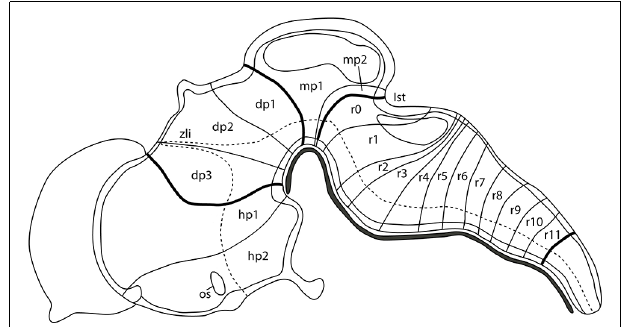
FIGURE 1 | Schematic representation showing the neuromeric units of the developing mouse brain along its anterior-to-posterior axis: two hypothalamo-telencephalic prosomeres (hp1, hp2), three diencephalic prosomeres (dp1, dp2, dp3), two midbrain prosomeres (mp1, mp2), and 13 hindbrain rhombomeres (r0-r11). The dotted line defines the limit between the alar and basal plate of the developing neural tube. Ist, isthmus; os, optic stalk; zli, zona limitans intrathalamica. Adapted from Puelles